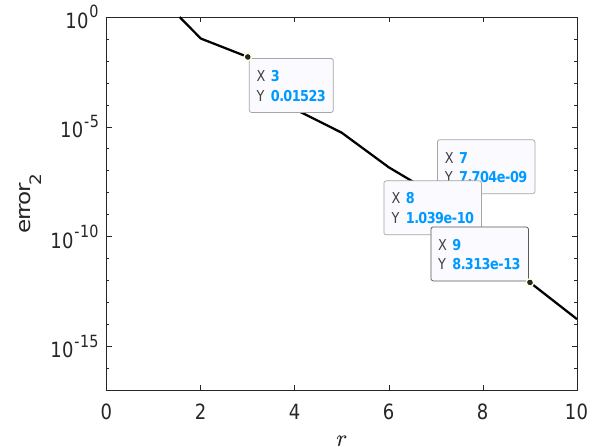
Figure 39. Convergence graph of y 2